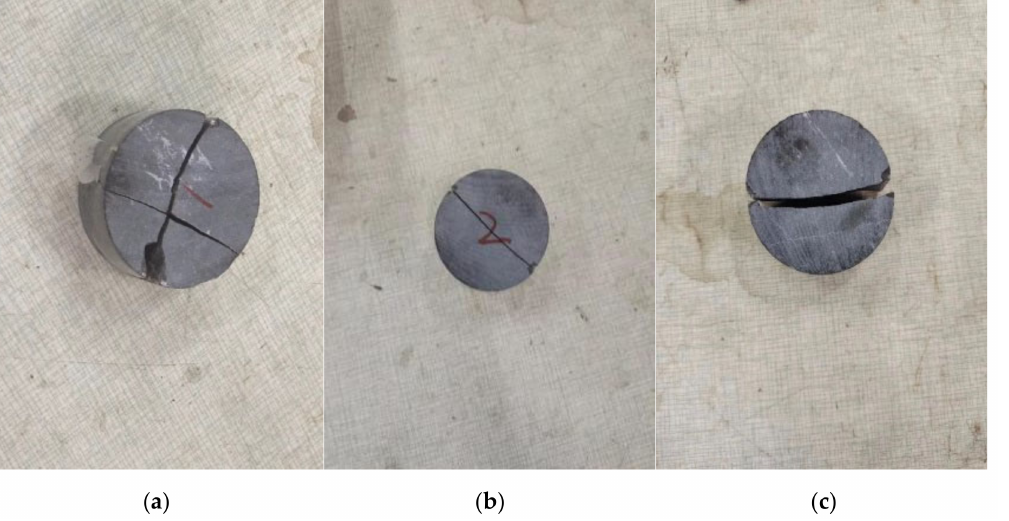
Figure 4. Rock failure mode of Brazilian splitting test. ( a ) Sample B-1; ( b ) Sample B-2; ( c ) Sample